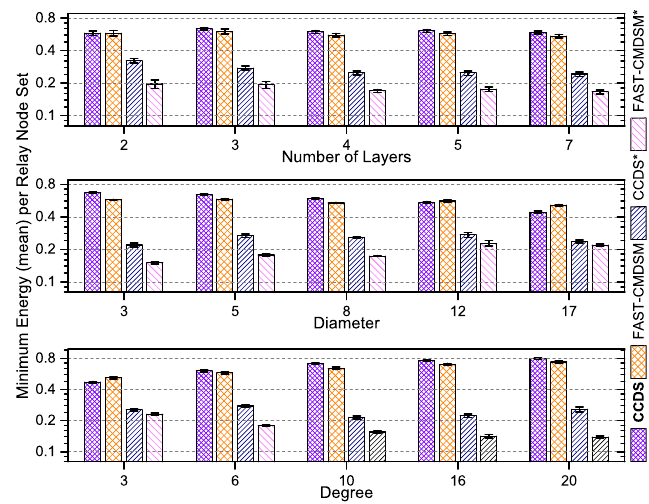
Figure 17. Energy awareness of the competitors (Medium skewness).